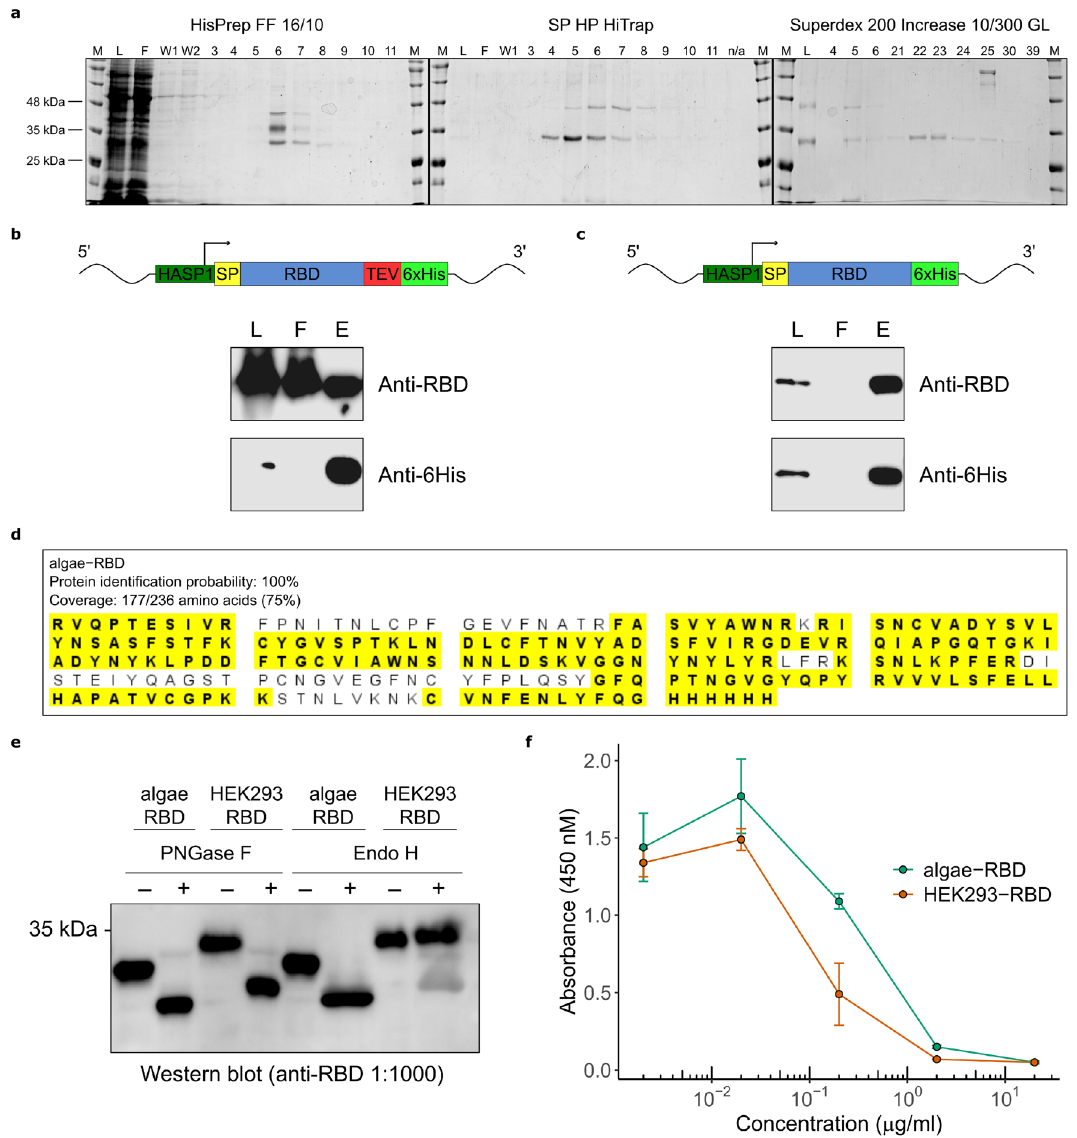
Figure 4. Purification and activity of the algae-RBD. ( a ) Representative gel images of individual chromatographic steps in the purification, starting with the HisPrep FF column on the left. For each step, numbers above the gel indicate elution fractions. M, BLUelf Prestained Protein Ladder. ( b ) Western blots with an anti-RBD or anti-6XHis antibody of the load (L), flow through (FT) and elution fraction 6 (E) from the HisPrep FF column purification of the algae-RBD construct with a TEV protease site. ( c ) Western blots as in panel ( b ) of a purification of an algae-RBD construct lacking the TEV protease sie. ( d ) Protein identification of the algae-RBD by MALDI MS. The amino acid sequence of the algae-RBD is shown and peptides identified are highlighted in yellow. ( e ) Endoglycosidase digestion assays to detect N -linked glycosylation. Purified algae-RBD or HEK293-RBD were incubated with (+) or without (−) the indicated glycosylase and visualized by western blotting with a polyclonal anti-RBD antibody. ( f ) ACE2 inhibition binding assay. Shown is a plot of absorbance readings of ACE2-bound Fc-tagged RBD at various concentrations of algae-RBD or commercially available RBD made in HEK293 cells (HEK293-RBD). Data are three independent experimental replicates with error bars representing standard deviation of the mean. Uncropped gel images for panels ( a ), ( b ), ( c ), and ( e ) are shown in Supplementary Figures